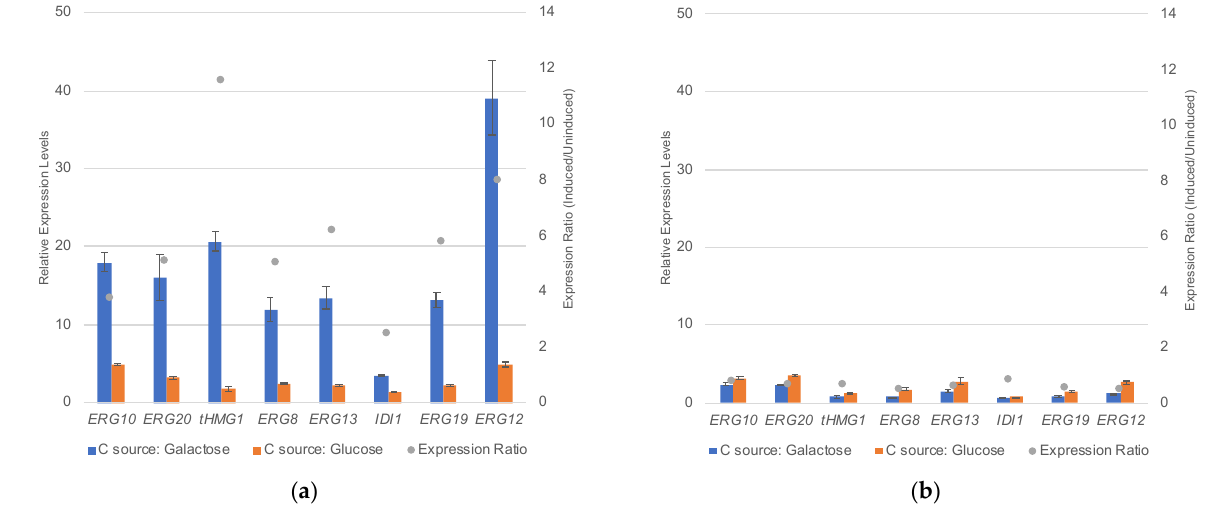
Figure 3. Real-time PCR (RT-PCR) analysis of mevalonate pathway genes in engineered strains FPPY005_39850 ( a ) and BCC39850hlu ( b ).